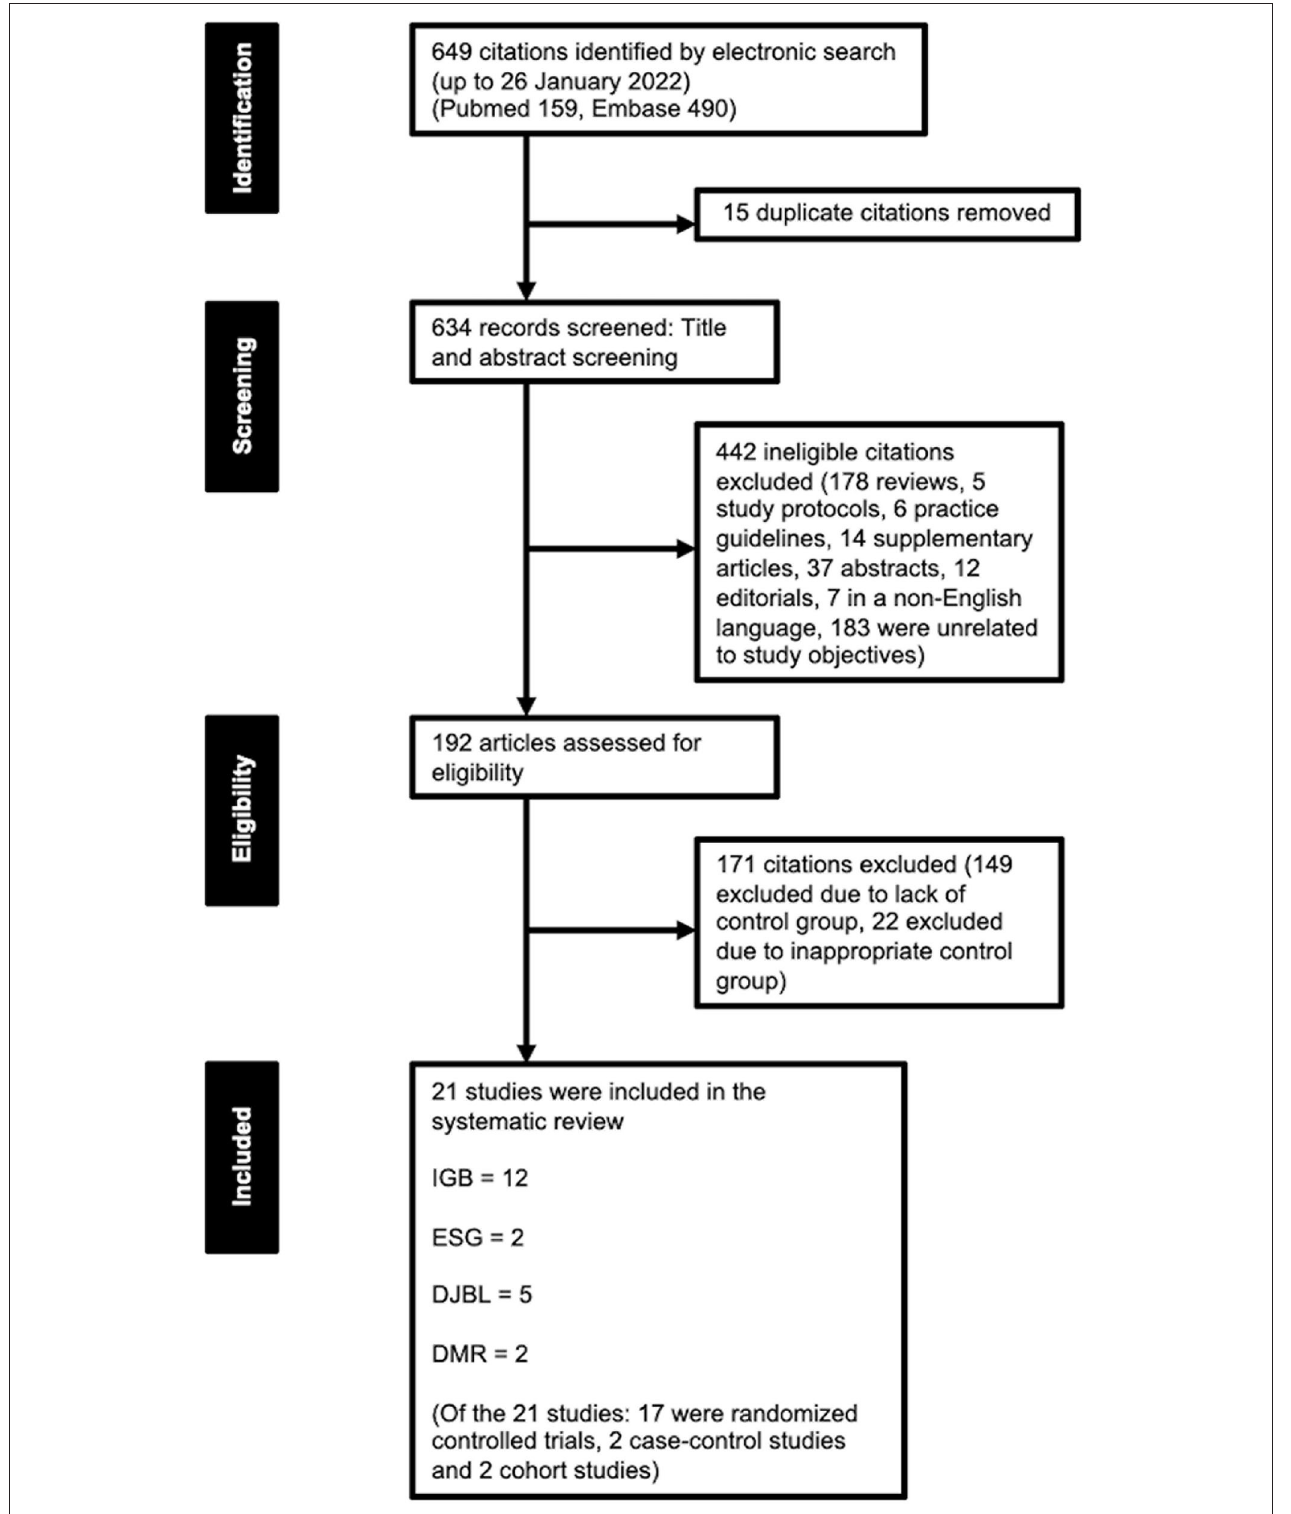
FIGURE 1 | Summary of study selection